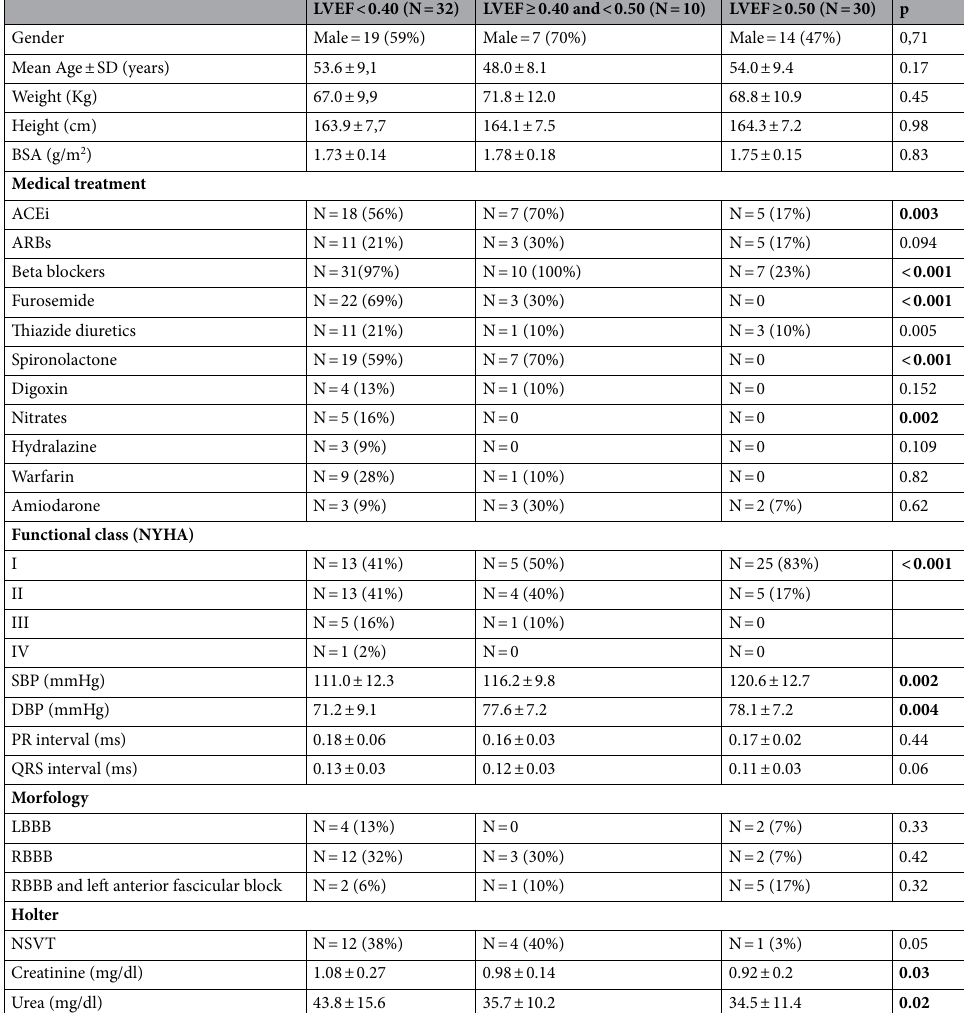
Table 1. Clinical, anthropometric and electrocardiographic data. Significant values are in bold. * LVEF Left ventricular ejection fraction, SD Standard deviation, BSA Body surface area, SAH Systemic